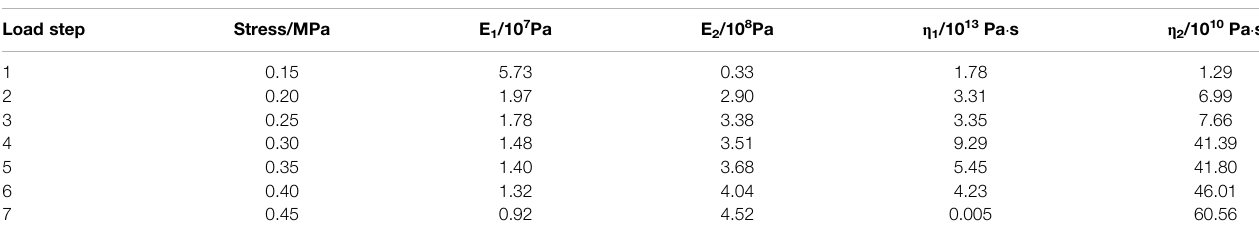
TABLE 4 | Creep parameters of saturated Q 2 loess sample No. 1